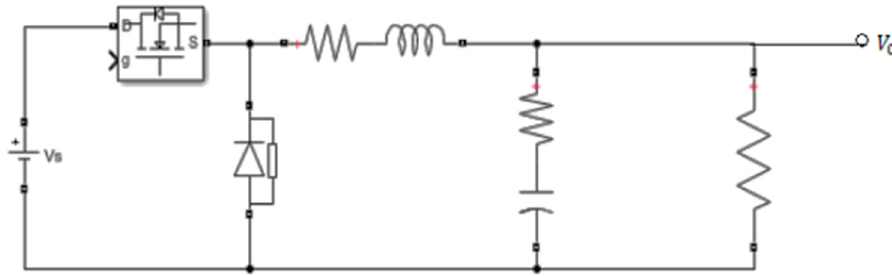
Figure 25. DC–DC converter model.